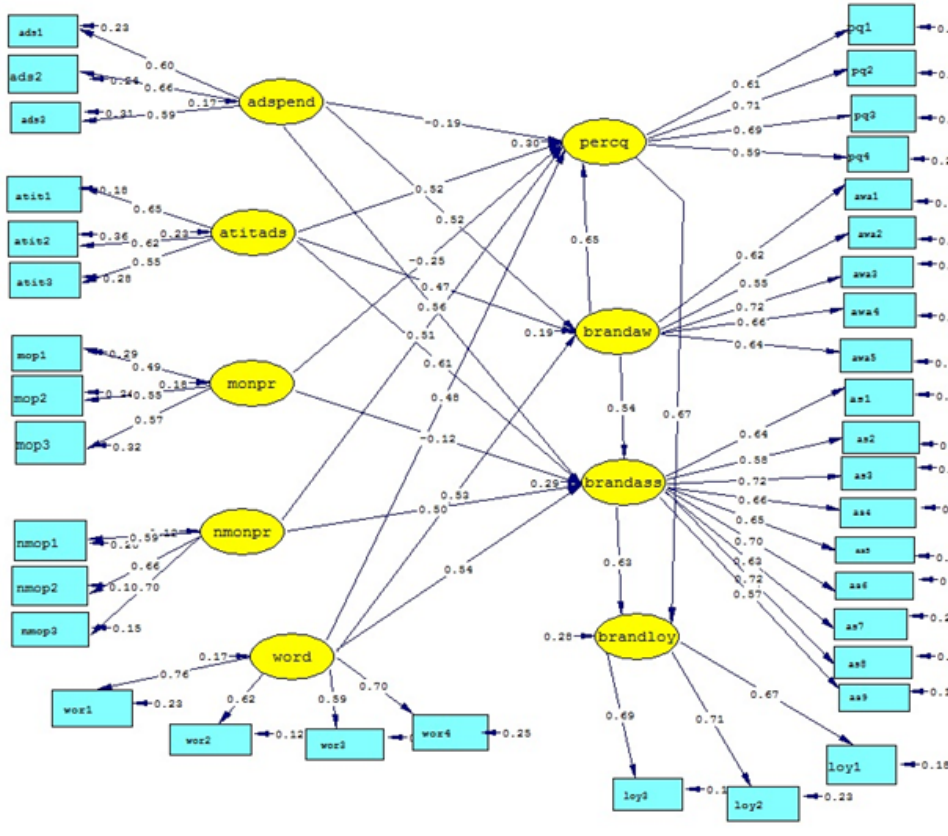
Fig. 2. The result of structural equation